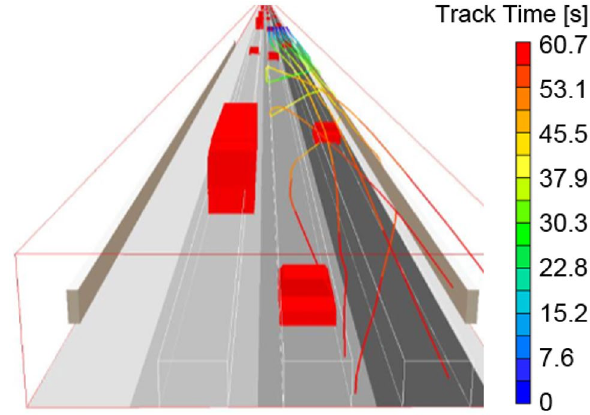
Fig. 5 Air trajectories with reactors at the tube exits. Displayed is the view from the tube’s exit (against travel direction). The active ventilation forms a vortex in the airstream of the tunnel. Coloring indicates the trajectories track